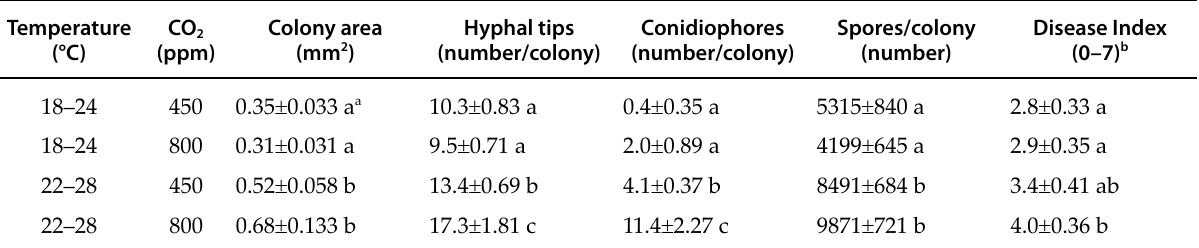
Table 8. Mean pathogen parameters and disease indices for powdery mildew on zucchini plants grown in different tem - perature and CO 2 regimes. Data are shown as means ± SE (n